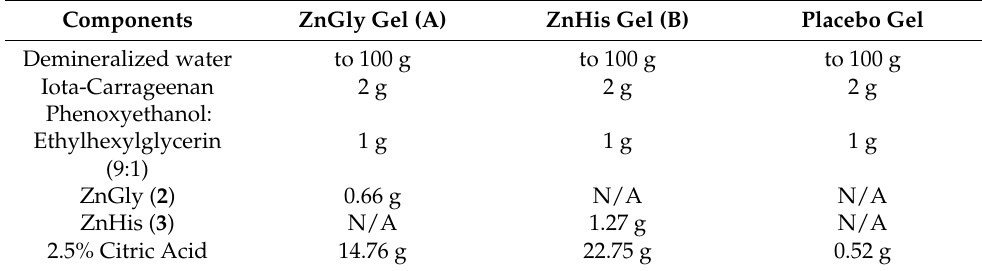
Table 7. Detailed composition of gel